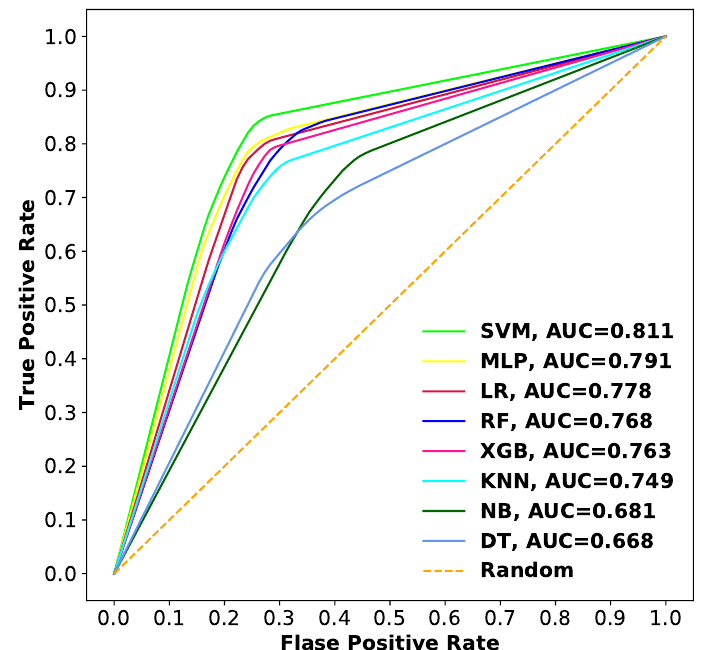
Figure 9. ROC comparison of different classifiers with corresponding AUC values using 10-fold cross-validation.